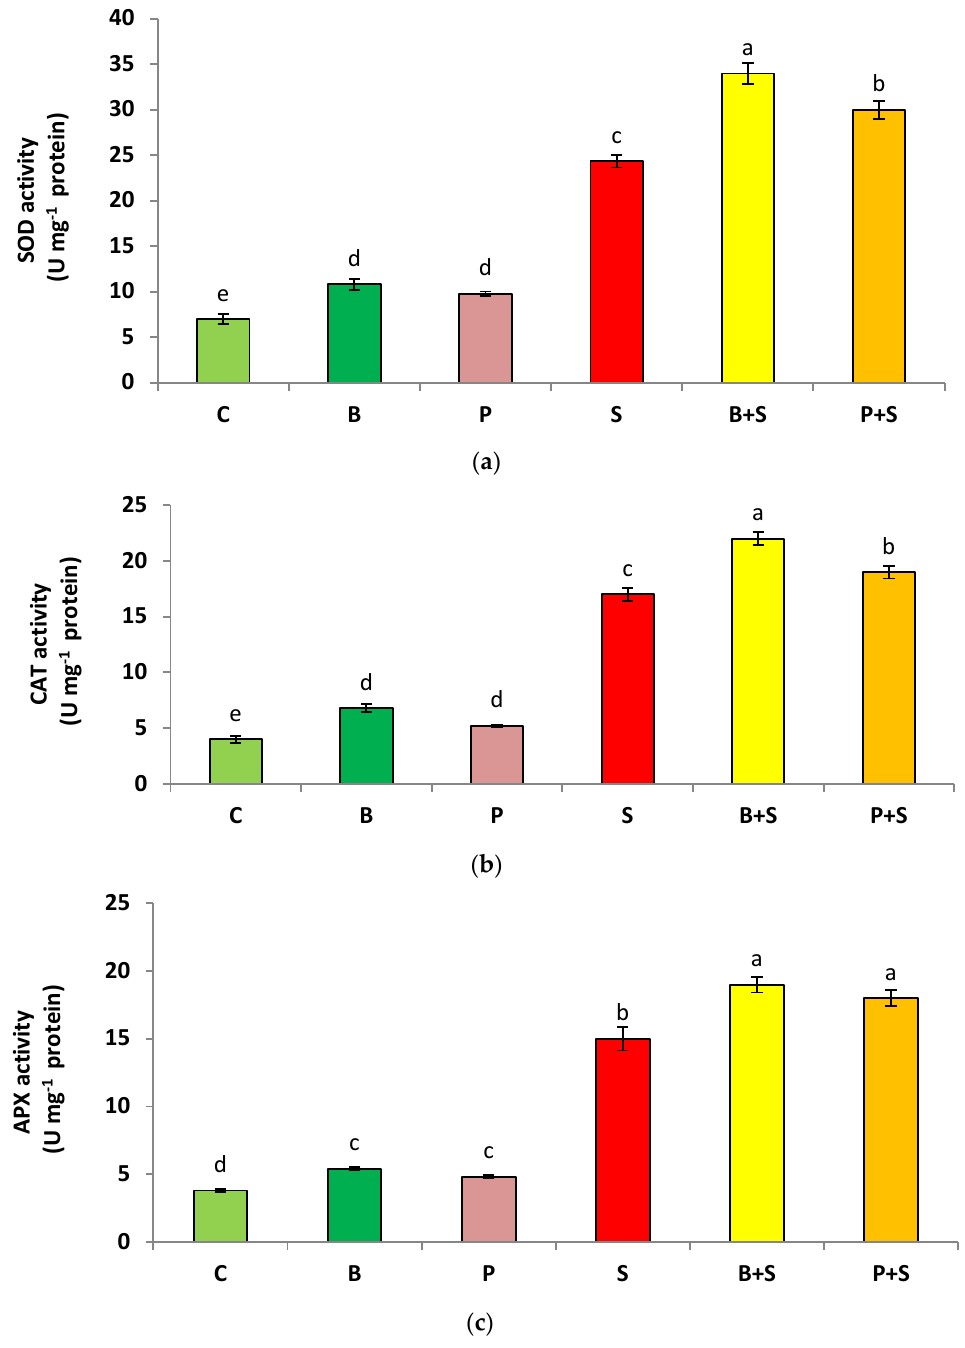
Figure 4. Effect of BABA and PEG seed priming on SOD ( a ), CAT ( b ), and APX ( c ) activities in cowpea seedlings exposed to PEG stress. C (control), B (BABA-primed seedlings without any stress), P (PEG-primed seedlings without any stress), S (non-primed seedlings subjected to PEG stress), B + S (BABA-primed seedlings subjected to PEG stress), P + S (PEG-primed seedlings subjected to PEG stress). Values represent the mean ± SE of three independent experiments. Alphabetical letters show significant difference between treatments performed using Duncan’s multiple range test.